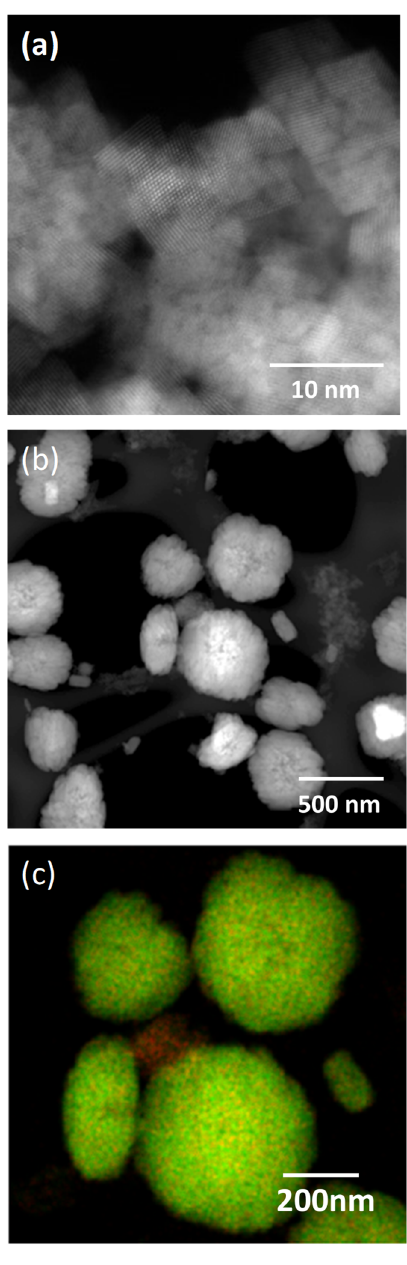
Figure 3. STEM HAADF imaging and EDS mapping of nanoparticles generated by HMTA: ( a ) HAADF of CeO x and ( b ) HAADF of Eu:CeO x ; ( c ) Ce and Eu L map of the Eu:CeO x NPs (Eu L— red , Ce L— green ).